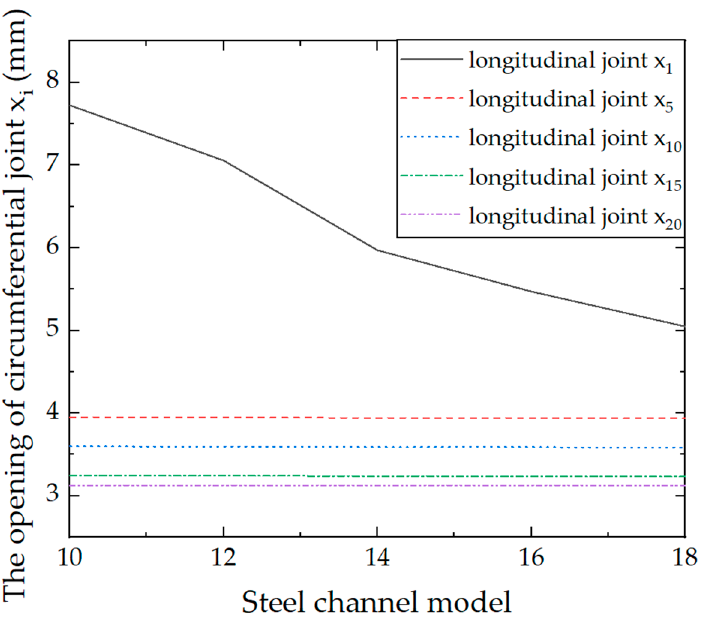
Figure 20. The relationship curve between steel channel models and the opening of circumferential joints for different rings.